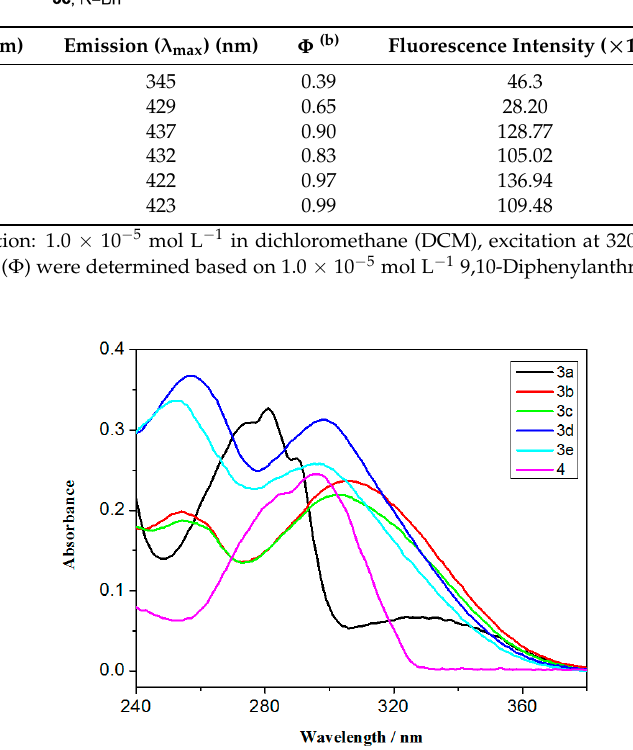
Figure 1. The absorption spectra of compounds 3 ( a – e ), 4 .